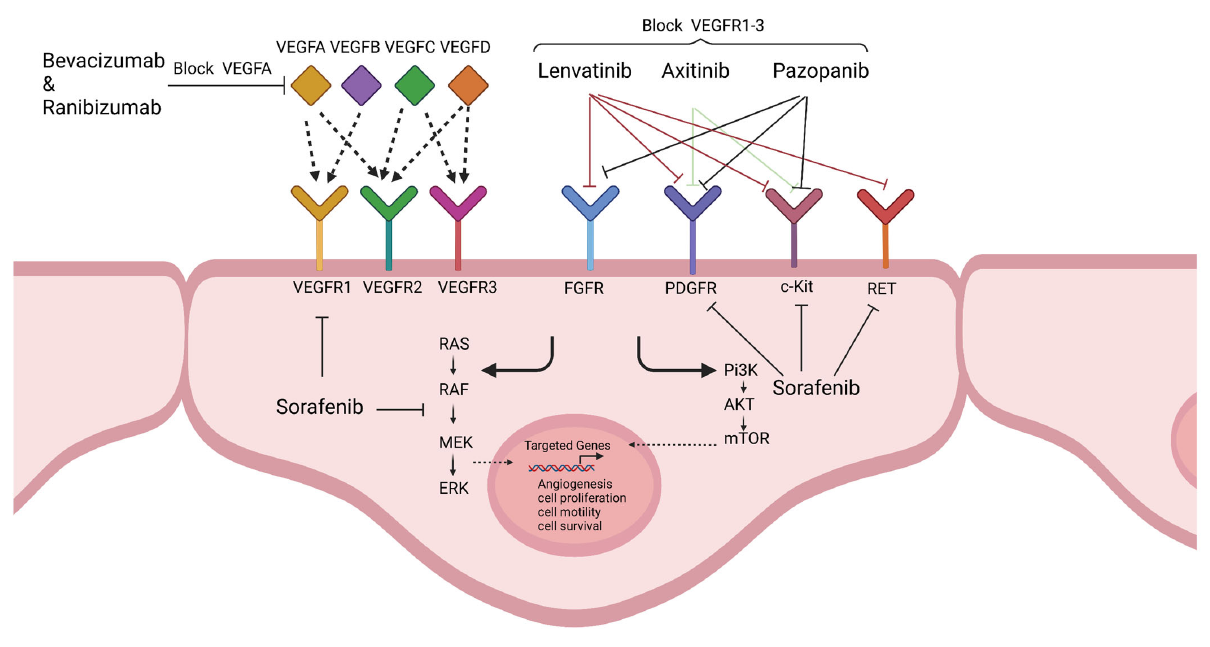
Figure 3. Mode of action of FDA-approved anti-angiogenic drugs used in melanoma clinical trials. Bevacizumab is the monoclonal antibody against VEGFA, and it inhibits the interaction of VEGFA with VEGFR1 and VEGFR2. Ranibizumab is a recombinant monoclonal antibody against VEGFA with similar action as Bevacizumab. Sorafenib inhibits kinases that target VEGFR1 ‐ 3, PDGFR β , RET, c ‐ Kit, RAF ‐ 1, and BRAF. Lenvatinib is a multiple kinase inhibitor of VEGFR1 ‐ 3, PDGFR, FGFR, RET, and c ‐ Kit. Axitinib inhibits the VEGFR1 ‐ 3, PDGFR, and c ‐ Kit, and Pazopanib blocks the VEGFR1 ‐ 3, c ‐ Kit, PDGFR, and FGFR. Created with BioRender.com.